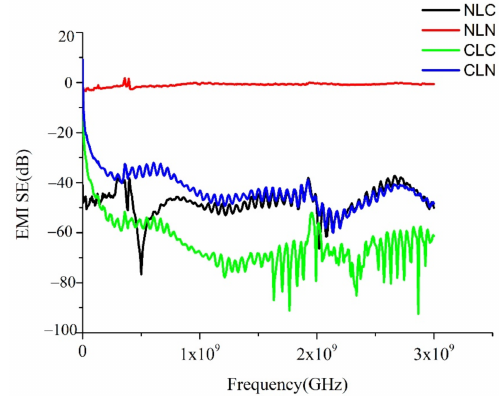
Figure 6. s of the NLC, NLN, CLC, and CLN